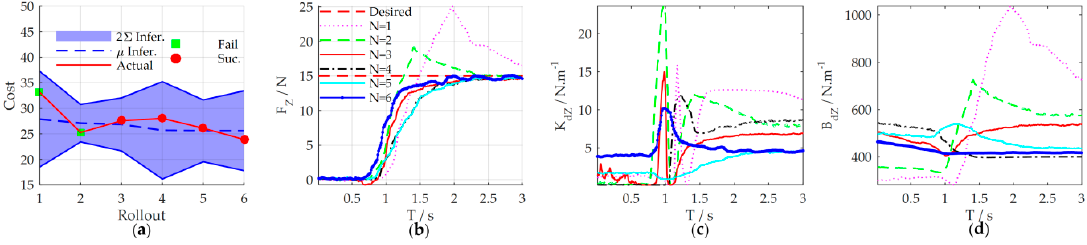
Figure 19. Experimental results of environmental adaptability. ( a ) Cost curve; ( b ) contact force; ( c ) Cartesian stiffness schedules; ( d ) Cartesian damping schedules.